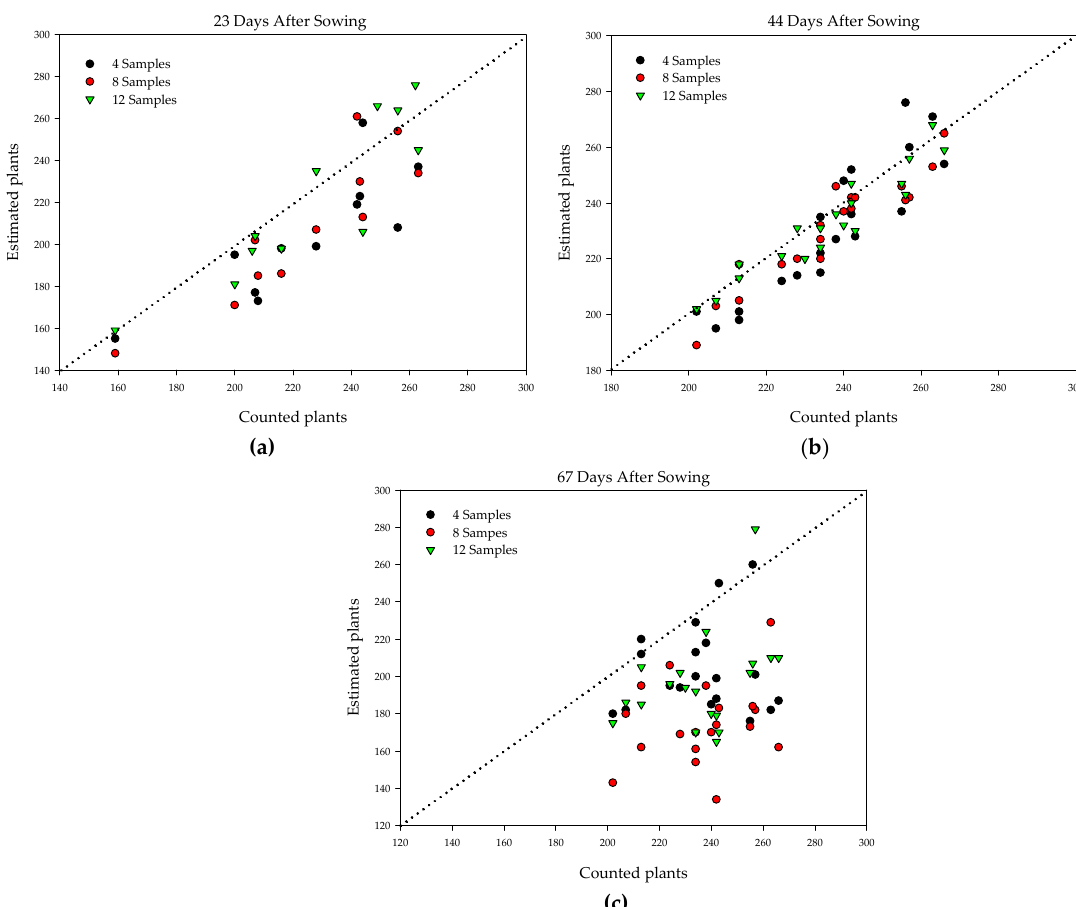
Figure 6. Manual count and automatic count through NCC of corn plants at different days after sowing (DAS). ( a ) corn plant count at 23 DAS (V2 stage) through NCC; ( b ) corn plant count at 44 DAS (V5 stage) through NCC; ( c ) corn plant count at 67 DAS (V9 stage) through NCC.